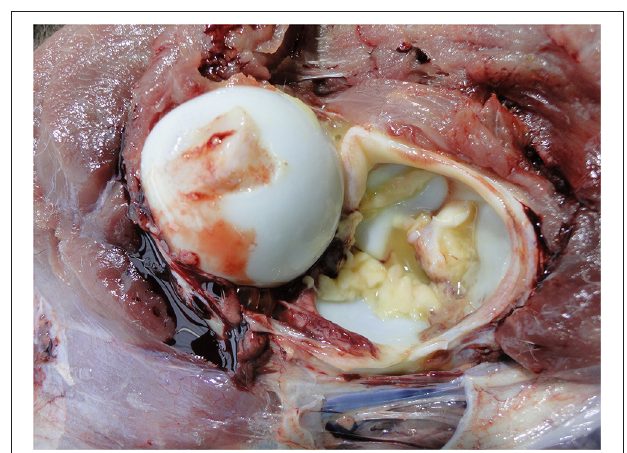
FIGURE 15 | Infection in the hip joint (arthritis) in a